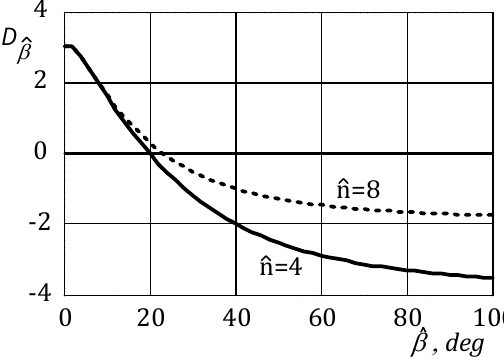
Figure 2. The dependence of D ˆ